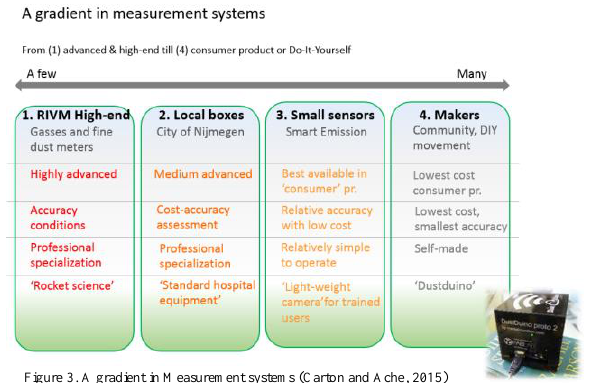
Figure 3. A gradient in Measurement systems (Carton and Ache,